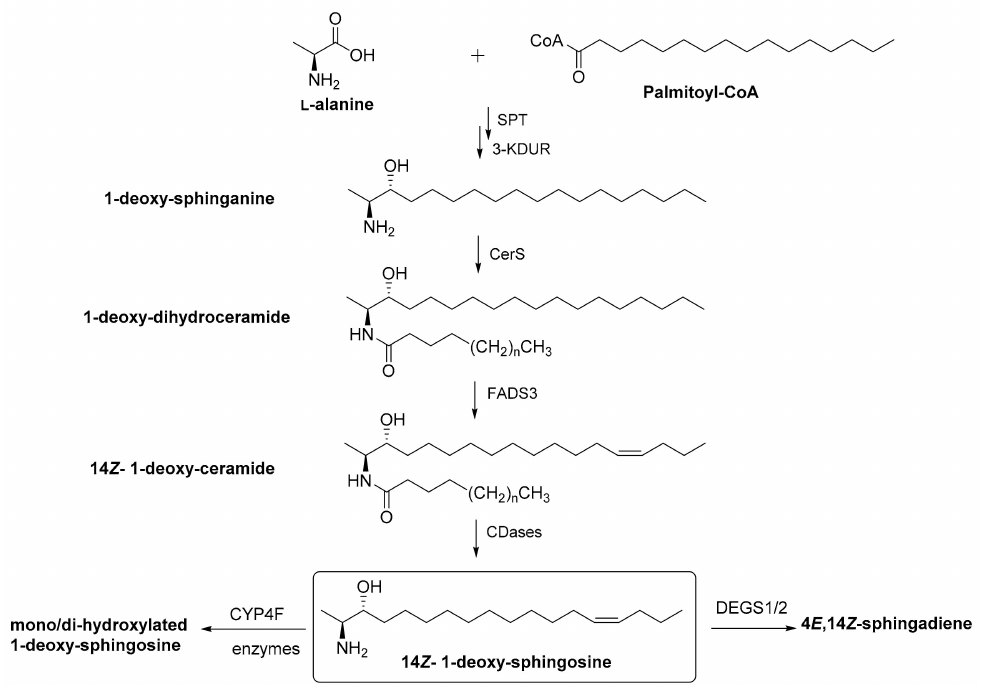
Figure 2. Metabolism of non-canonical sphingolipids. SPT enzyme can utilize L-alanine as a substrate, instead of L-serine, which leads to the formation of a family of atypical sphingolipid metabolites. The exact metabolic pathway of this lipid family is still elusive. SPT, serine palmitoyl transferase; 3-KDHR, 3-keto-reductase; CerS, ceramide synthases; FADS3, fatty acid desaturase 3; CDase, ceramidase; DEGS1/2, desaturase 1/2; CYP4F, cytochrome P450 (CYP)4F